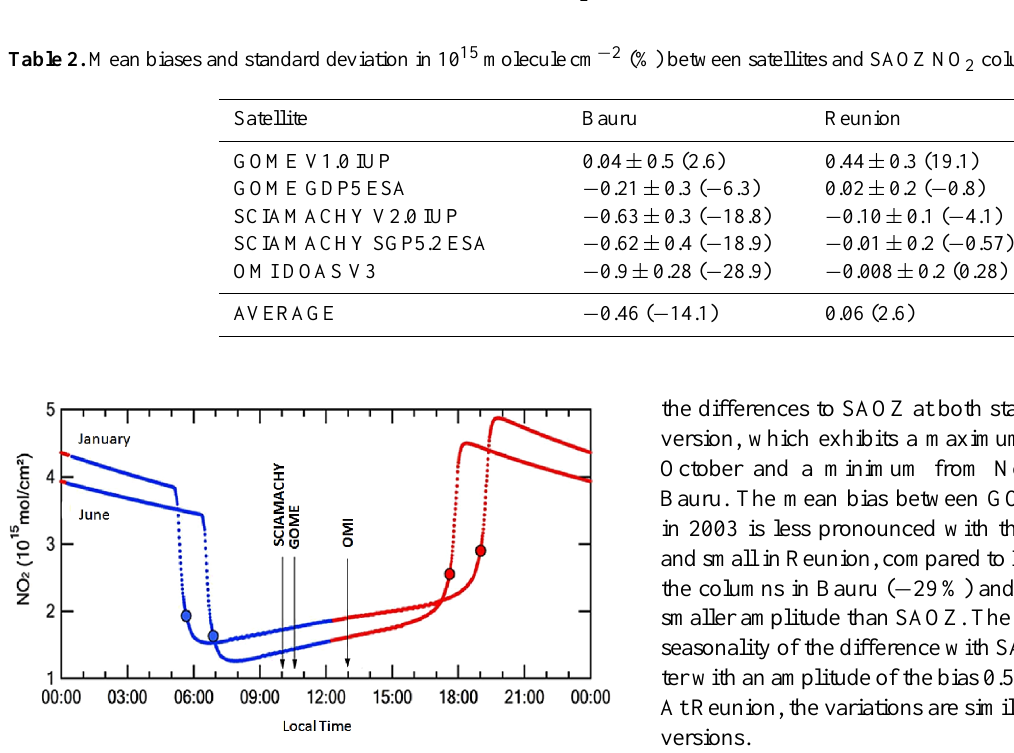
Figure 12. Simulated NO 2 column diurnal variation in the tropics in January and July. The markers show the time of sunrise (blue) and sunset (red) SAOZ measurements at 90 ◦ SZA and the arrows that of ERS-2 GOME, Envisat SCIAMACHY and Aura OMI